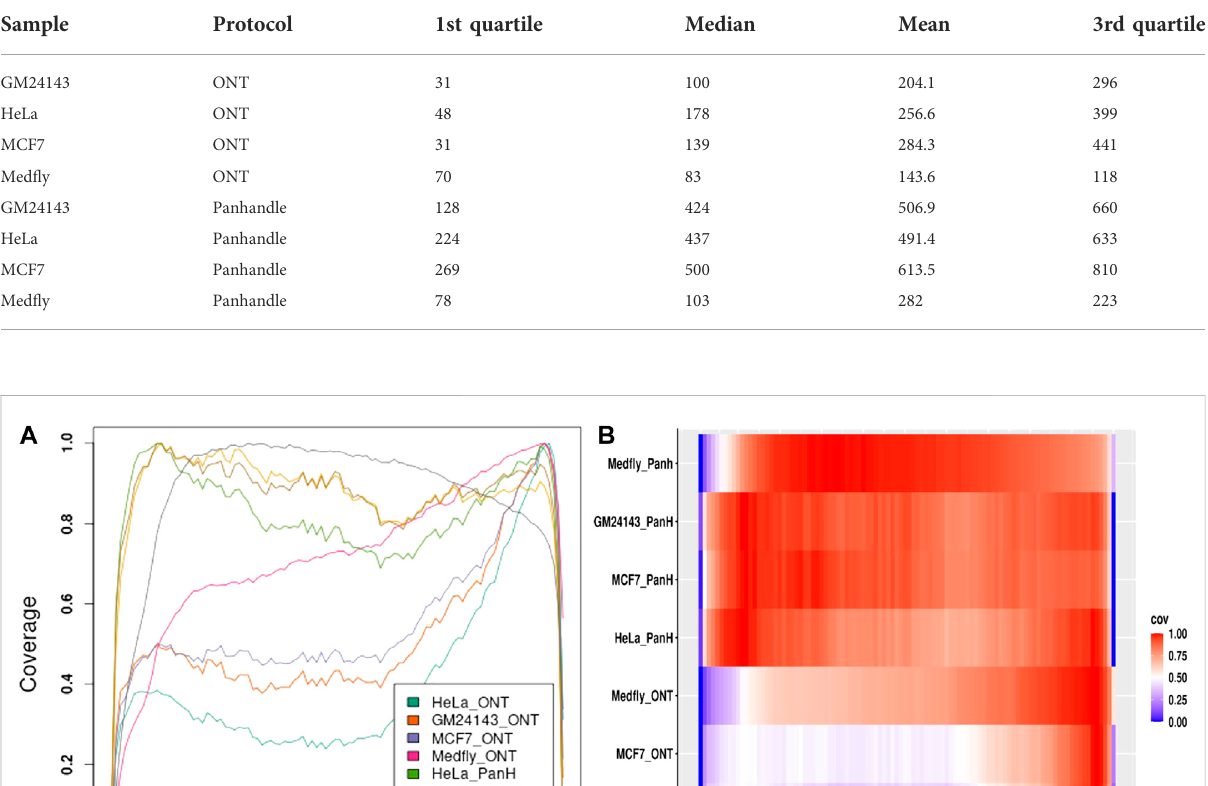
TABLE 4 Processed Pass read statistics. Following cDNA-PCR sequencing on the PromethION of 4 samples processed either with ONT or Panhandle protocols, Pass reads were trimmed of all adapters and poly(A) tail and the distribution of their lengths measured. All presented fi gures are in basepairs.